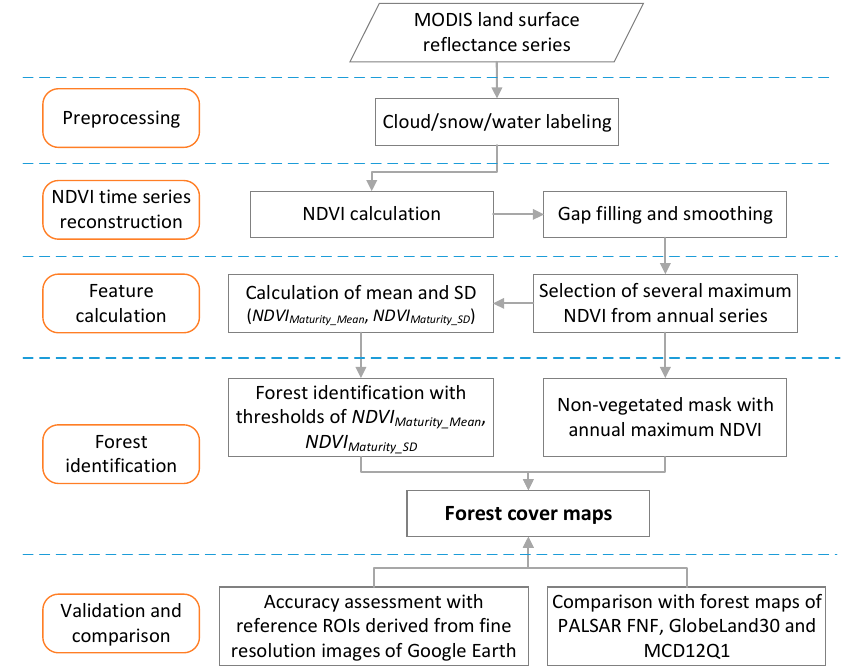
Figure 2. Workflow of the proposed method for forest cover mapping. (1) Step 1: reconstruction of NDVI time series. The NDVI was calculated with clear-sky reflectance in red and near-infrared bands from MOD09A1 products, and gaps in its time series were filled and smoothed with the locally adjusted cubic spline capping (LACC) approach